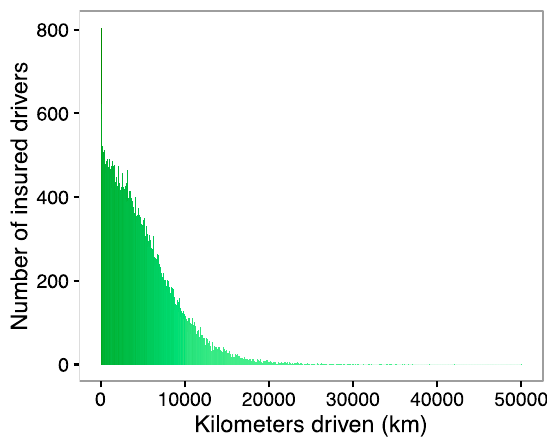
Figure 1. Distribution for the distance traveled for PAYD contracts in force in 2011.